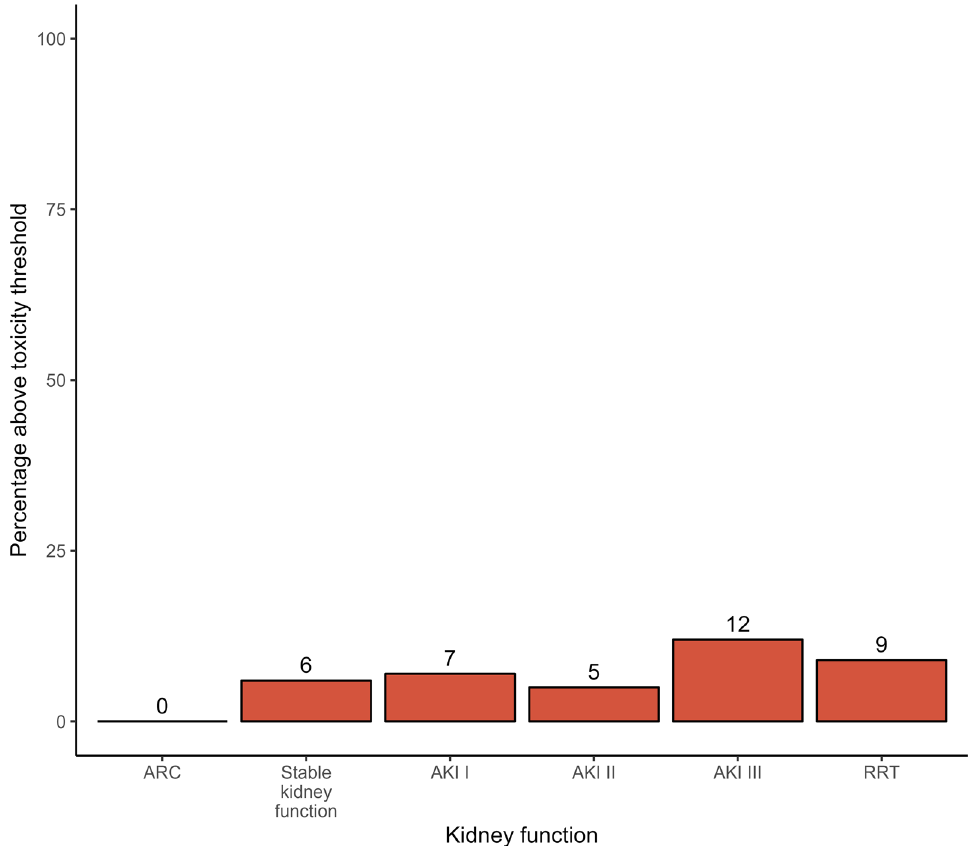
Fig. 9 Percentage of MEM samples above the toxic threshold according to renal